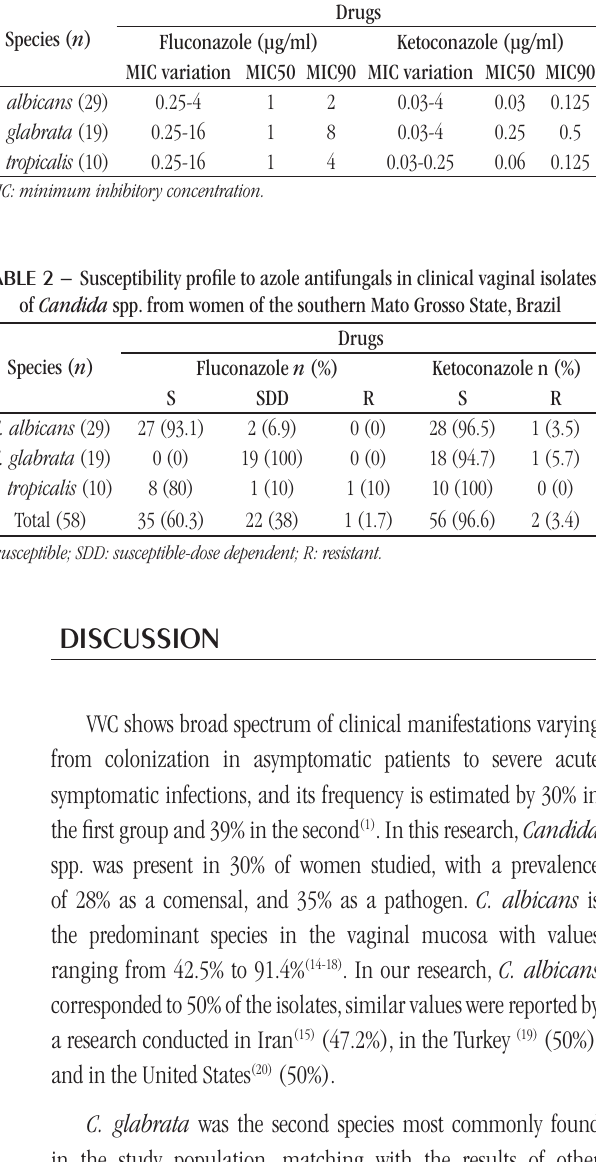
taBLE 1 − Variation of the MIC to azole antifungals in clinical vaginal isolates of Candida spp. from women of the southern Mato Grosso State, Brazil Species ( n